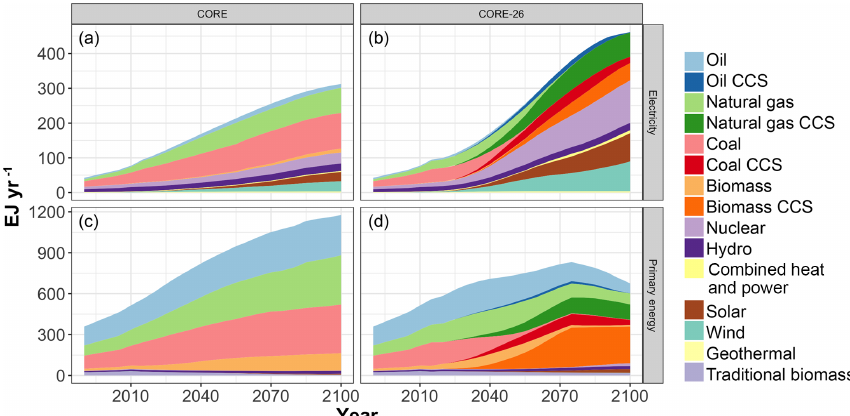
Figure 5. Global electricity generation (a, b) and global primary energy consumption (c, d) for the CORE (a, c) and CORE-26 (b, d) scenarios. Primary energy is reported using a direct equivalent; that is, 1EJ of nuclear or renewable electricity is reported as 1EJ of primary energy